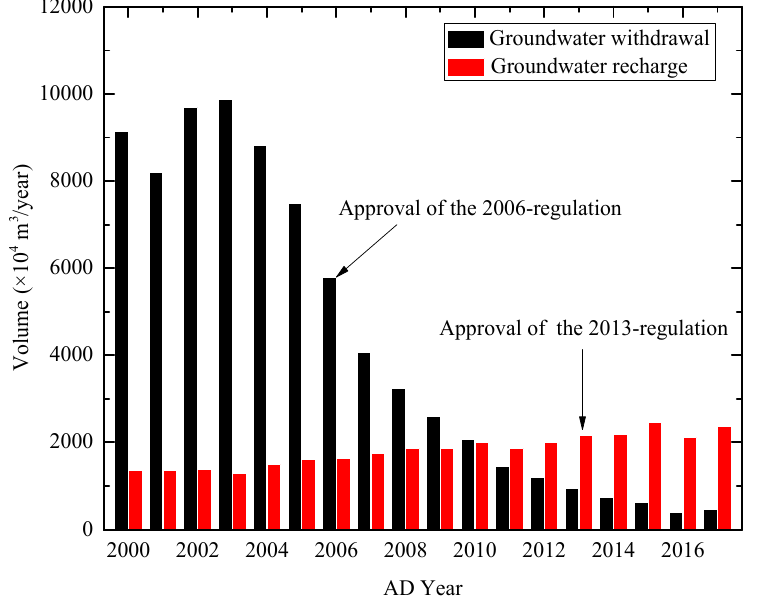
Figure 7. Volume of groundwater withdrawal and recharge in Shanghai from 2000 to 2017 (data from Reference [41]).